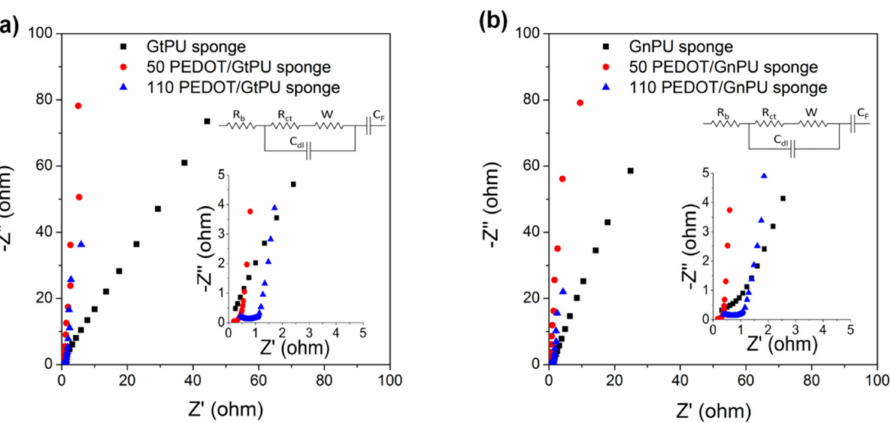
Figure 7. Nyquist plots for the symmetric supercapacitor cells assembled with GtPU, 50 PE- DOT/GtPU and 110 PEDOT/GtPU sponge ( a ), GnPU, 50 PEDOT/GnPU and 110 PEDOT/GnPU sponge ( b ). Nyquist plots were all obtained with 10 mV. The high frequency regions are showed as the